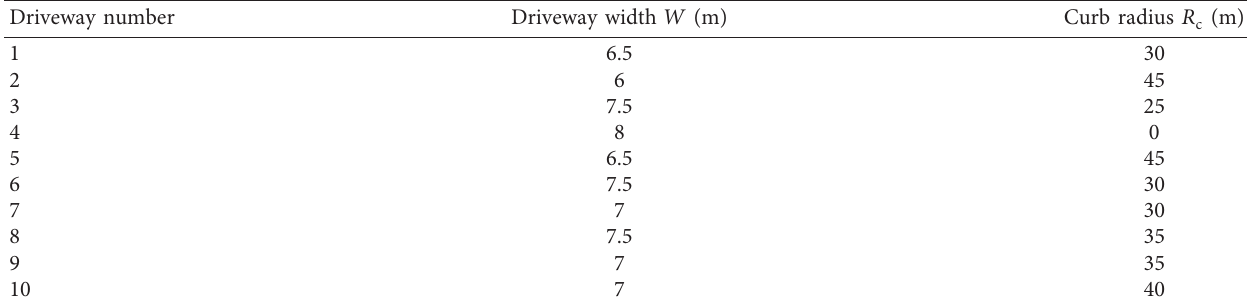
Table 12: Crash risk P